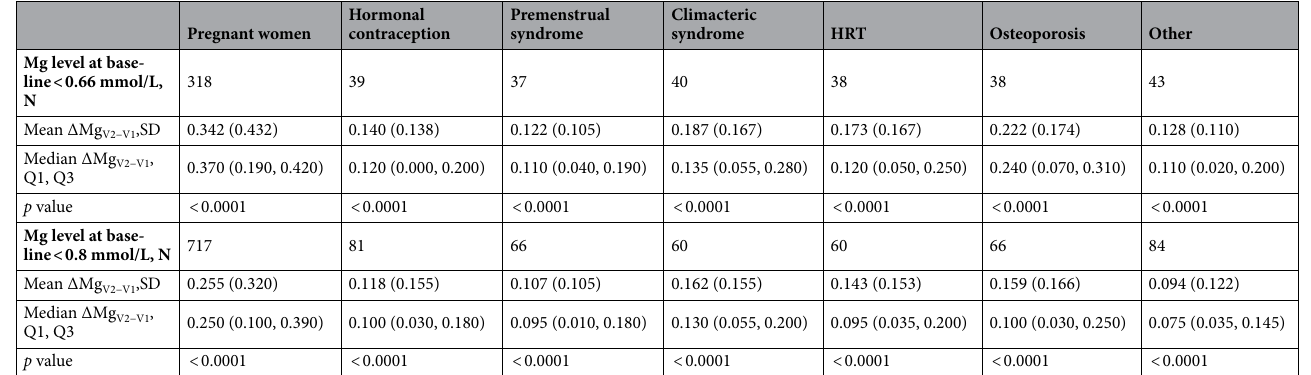
Table 1. Changes in serum Mg levels in pregnant women and women with hormone-related conditions from baseline to week 4 (ΔMg V2−V1 ). ΔMg V2−V1 , difference between Visit 1 and Visit 2 in serum Mg concentration; HRT hormone replacement therapy; Mg magnesium; N number of women; Q quartile; SD standard deviation; p values reflect whether serum Mg level changed significantly from baseline to week 4 (Wilcoxon signed-rank test).